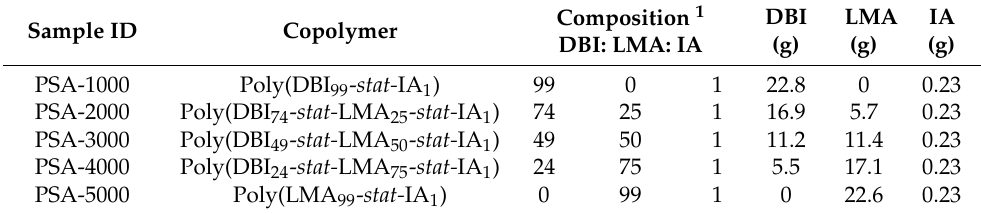
Table 1. Theoretical quantities of the latex